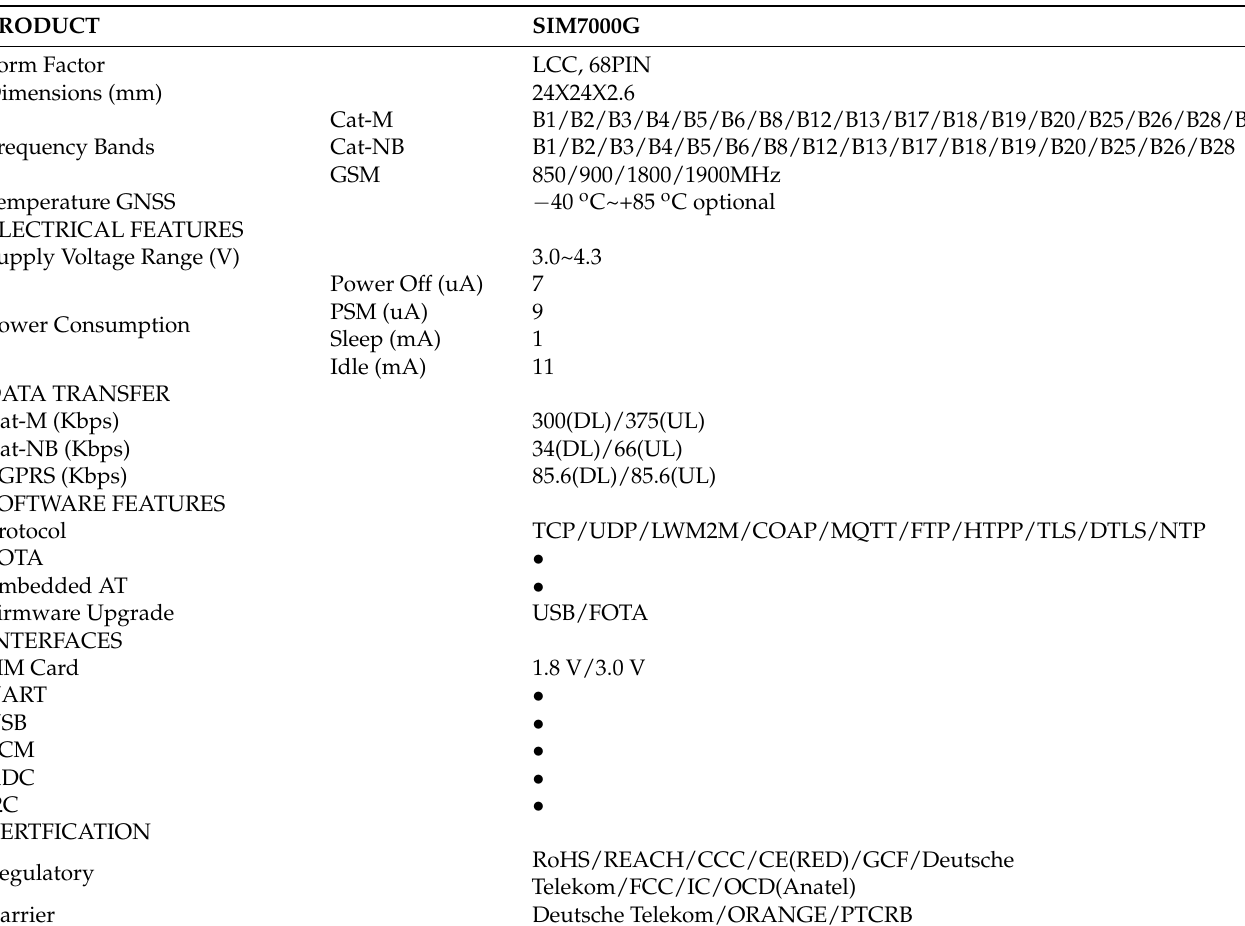
Table 4. SIMCOM 7000G modem